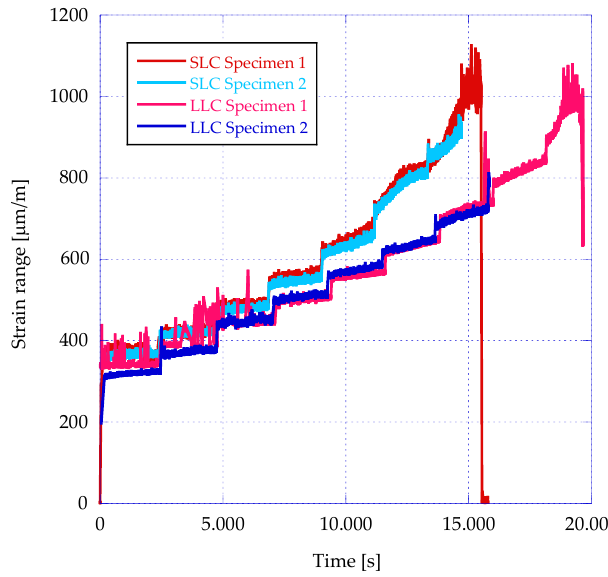
Figure 9. Range evolution for mixes LLC and SLC.